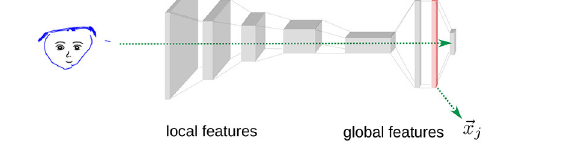
FIGURE3 The structure of the pretrained deep CNN of Simonyan and Zisserman (2014), consisting of five conjunctions of convolution and pooling layers, two fully connected layers, and the classification output layer. The input image is passed through the layers, and local or global features of the image can be extracted at early or later layers, respectively (as exemplified in the second fully connected